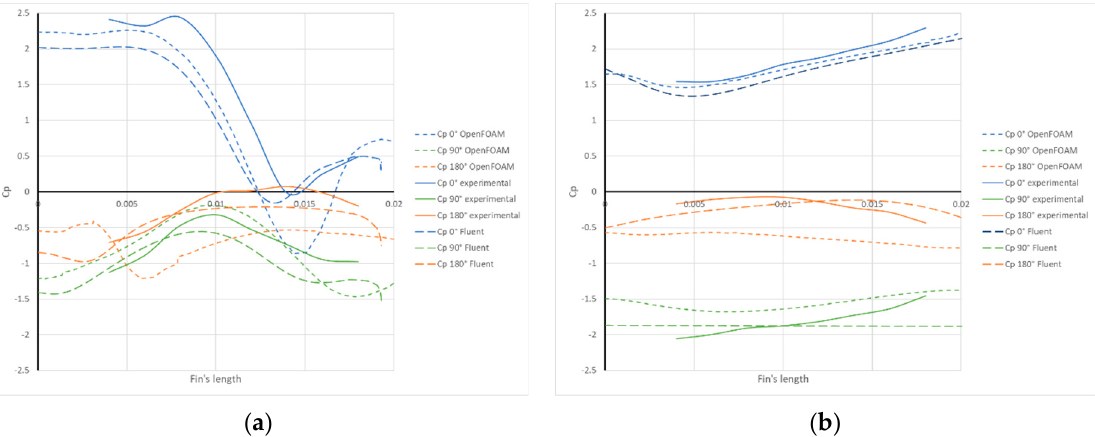
Figure 10. Pressure coefficient distribution obtained with experimental and numerical techniques at three different rotation angles: 0, 90, and 180 degrees. ( a ) Internal surface; ( b ) external surface of the inclined fin.